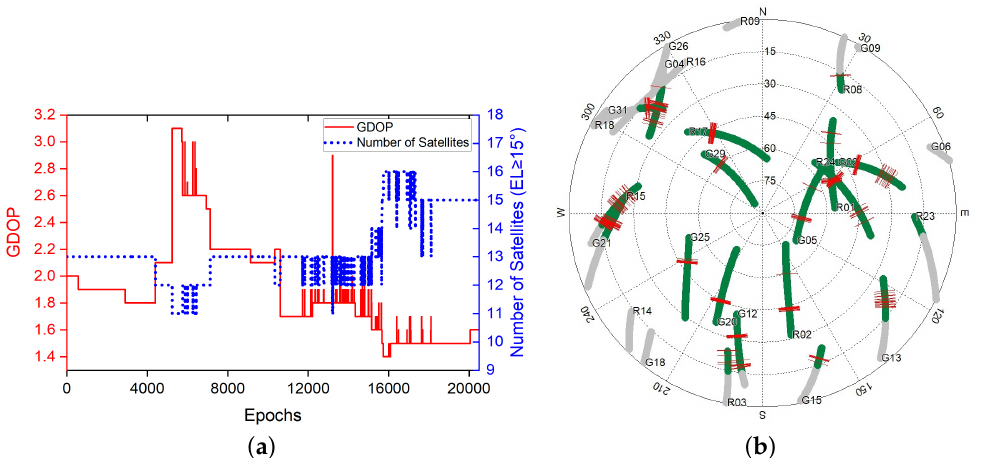
Figure 7. Geometric Dilution Precision (GDOP) and Sky Map during data sampling of experiment Section 3.2.2 ( a ) GDOP values and number of satellites. ( b ) Sky map of visible satellites, with a gray track indicating that the satellite’s altitude is less than 15 ◦ , and the red line indicates cycle slips.